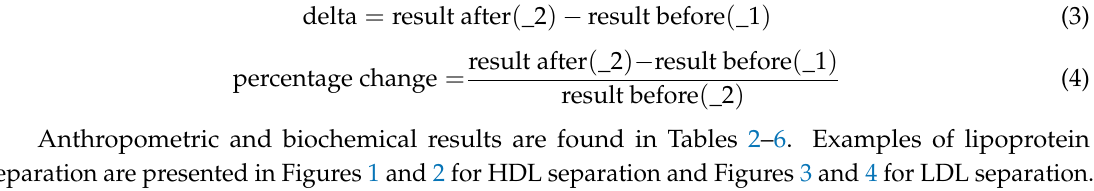
Table 2. Categorization of patients on the basis of change in Atherogenic Index of Plasma (AIP).